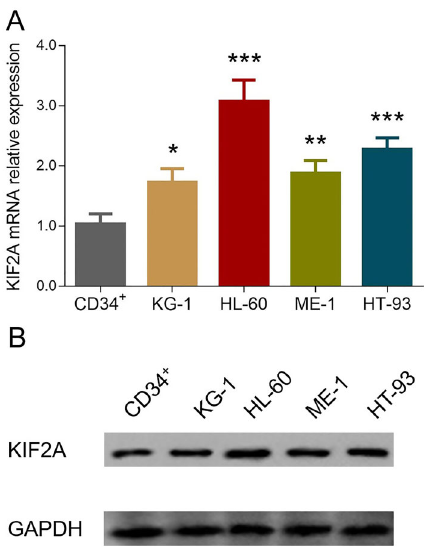
Figure 4. RT-qPCR experiments were carried out in triplicate, and western blot was performed once. A , KIF2A mRNA expression in various acute myeloid leukemia (AML) cell lines and CD34 + cells; B , KIF2A protein expression in various AML cell lines and CD34